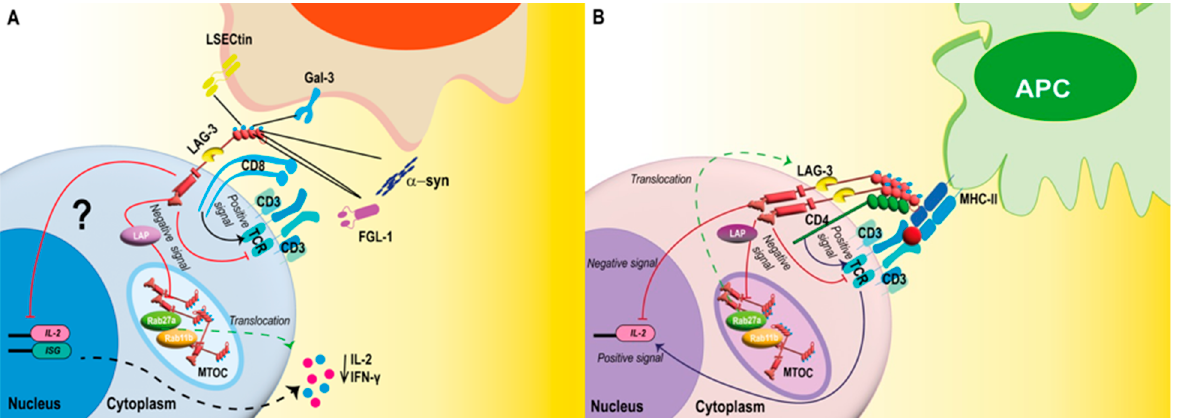
Figure 2. LAG-3 binds to various ligands activating an inhibitory signaling pathway in T cells. LAG-3 colocalizes in the membrane with the CD3/TCR complex and CD8 ( A ) or CD4 co-receptors ( B ). In CD8 + T cells, LAG-3 recognition occurs by alternative ligands (Gal-3, FGL-1, LSECtin, and α -syn). Gal-3 and LSECtin bind to LAG-3 through glycosylation sites, whereas FGL-1 binds to LAG-3 through the D1 and D2 domains, and α -syn binds to LAG-3 through the D1 domain ( A ). In these cells, LAG-3 downregulates the TCR leading to decrease secretion of IL-2 and IFN- γ ( A ). In CD4 + T cells, LAG-3 binds to its primary ligand, MHC-II. After the immunological synapse takes place, the CD4 co-receptors send positive signals to the nucleus that lead to the activation of Il-2 and the expression of this cytokine ( B ). In contrast, LAG-3 sends negative signals through its cytoplasmic domains. In both cases ( A , B ), the EP motifs recruit the LAP protein, which mediates LAG-3 transport and colocalization to the cell surface, enhancing the dimerization/oligomerization of LAG-3. This process is necessary for MHC-II/LAG-3 binding ( B ). The KIEELE cytoplasmic domain of LAG-3 is responsible for the inhibition of the first steps of the TCR pathway. KIEELE possesses a lysine residue that prevents the activation of transcription factors, including the IL-2 transcription factor ( B ).